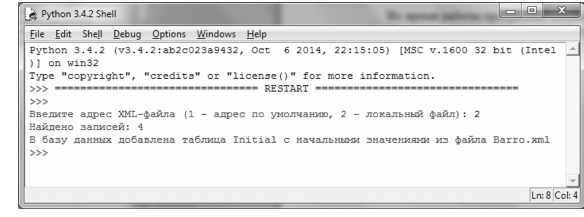
Fig. 4. Conversion of XML file to a database file.